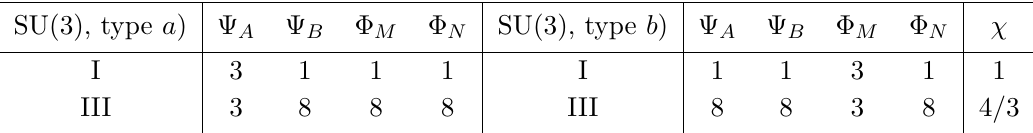
Figure 7 . Crossed box diagrams contributing to b ! s(cid:22) + (cid:22) (cid:0) transitions. The diagram on the left appears in models with real scalars, while the one on the right can be constructed in models with Majorana fermions.